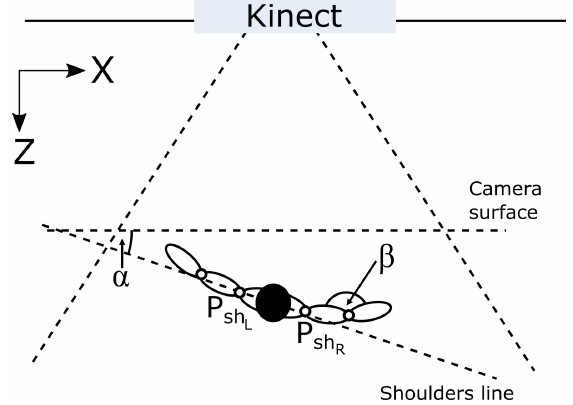
Figure 3. Rotation angle α between the user and Kinect.